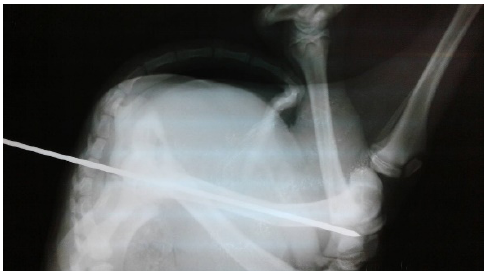
Fig. 12. Radiography during intramedullary pin of femur